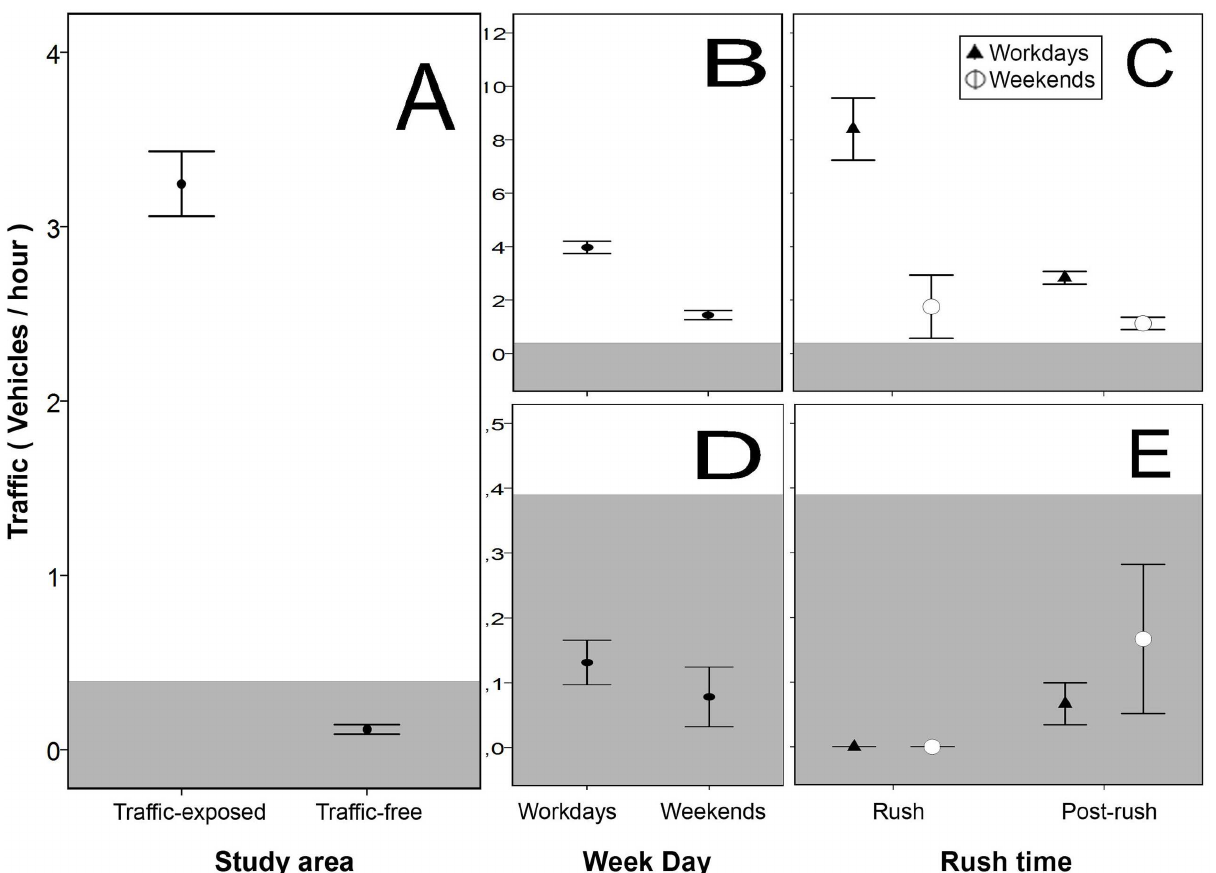
Fig 1. Spatio-temporal variability in daytime traffic intensity (vehicles per hour between 07:00 and 22:00h). (A) Average values in traffic-exposed and traffic-free areas. Traffic intensity across week days and accordingto rush time are presented separately for traffic- exposed (B-C) and traffic-free (D-E) areas. For ease of interpretation, the grey backgroundindicatestraffic intensity below 0.4 vehiclesper hour. Bars represent means ± SE.